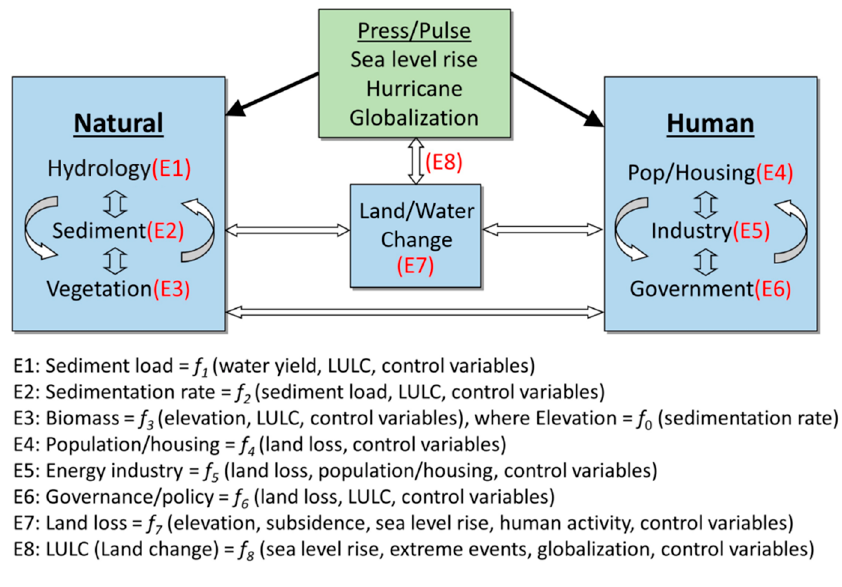
Figure 3. The Mississippi River Delta Coupled Natural-Human dynamics framework.